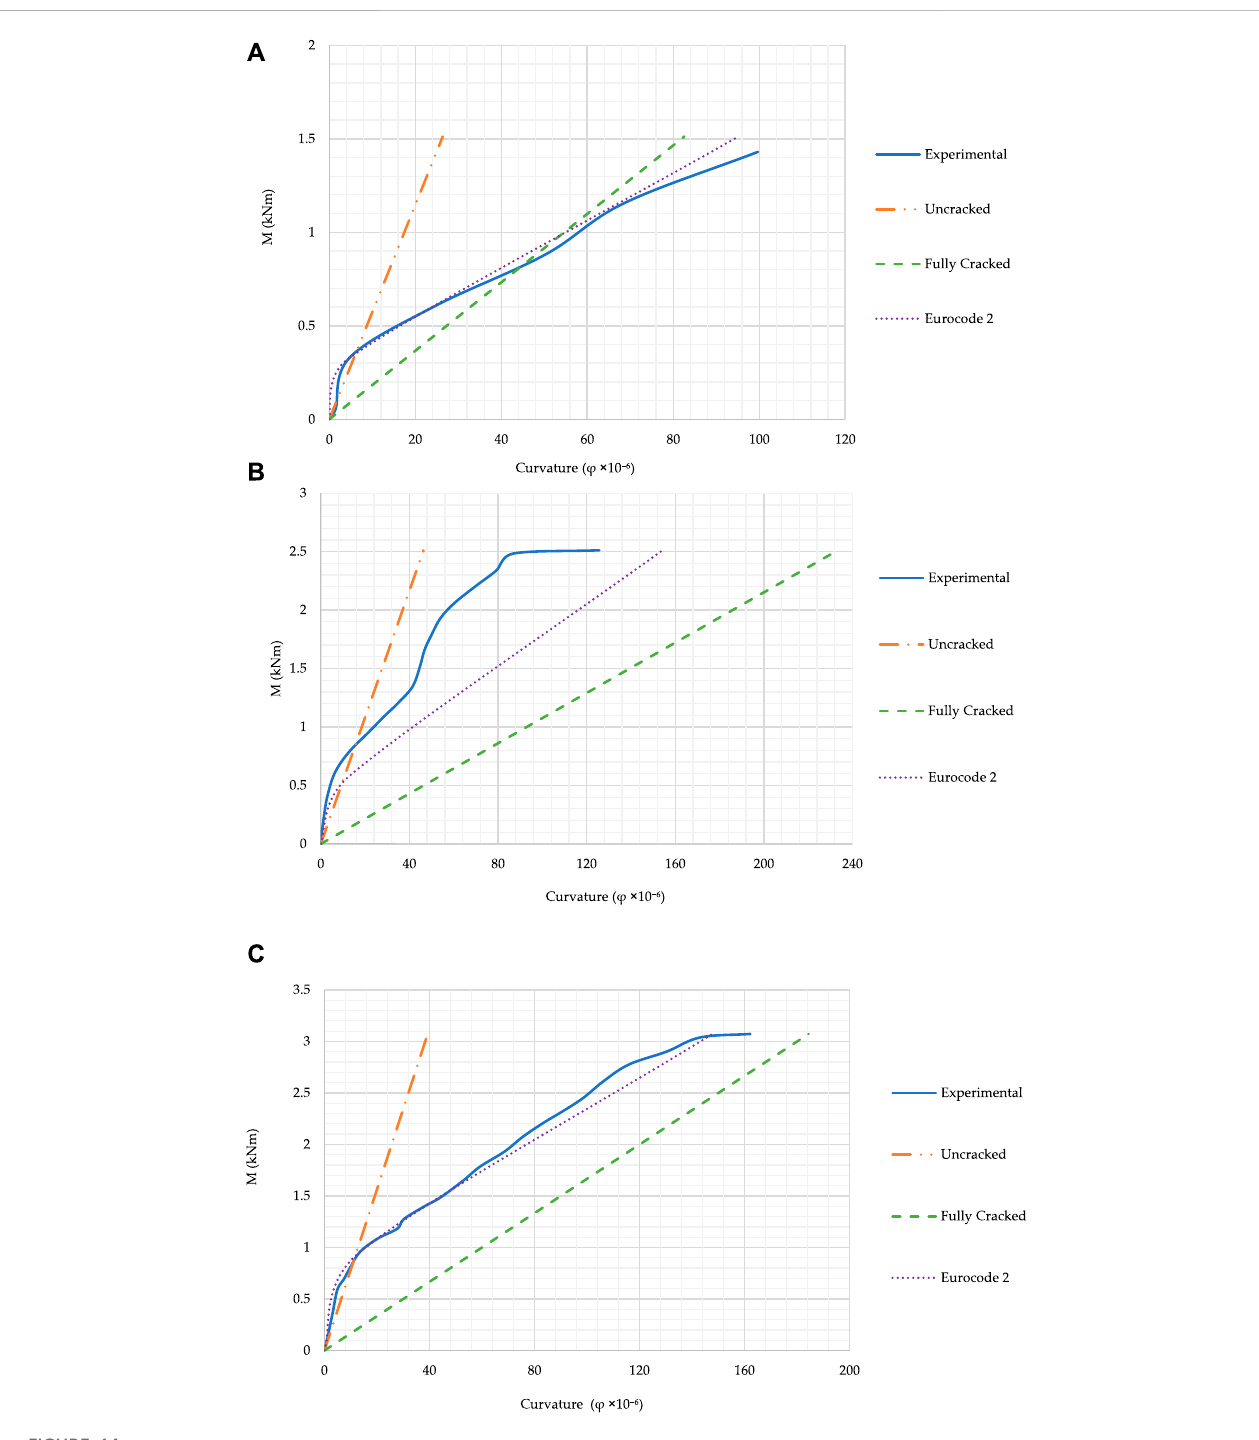
FIGURE. 14 Comparison of experimental and predicted moment-curvature curve for (A) SRC (B) SRC + 1T (C) SRC + 2T.